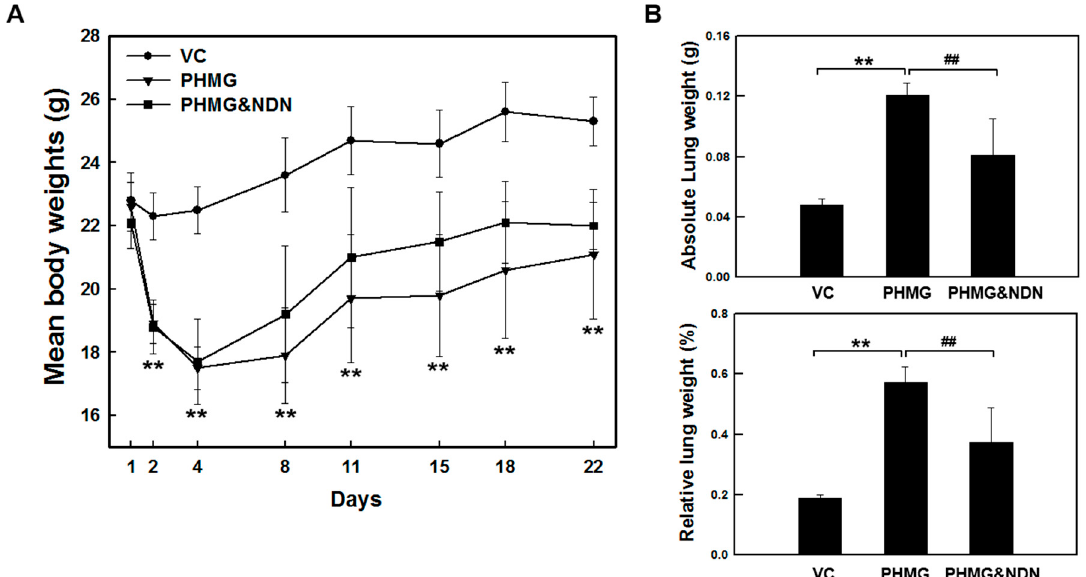
Figure 1. Effect of NDN on body and lung weights of PHMG-treated mice. Mice were intratracheally instilled with 1.1 mg/kg PHMG or saline on day 1. The PHMG & NDN group received an oral administration of NDN on days 1 and 21. The body weights were measured on the indicated days ( A ). The absolute lung weight was measured on day 22, and the relative lung weight was calculated as the ratio of the left lung weight to body weight of each mouse ( B ). Data are expressed as means ± SD ( n = 6/group). ** p < 0.01 vs. VC group, ## p < 0.01 vs. PHMG group.